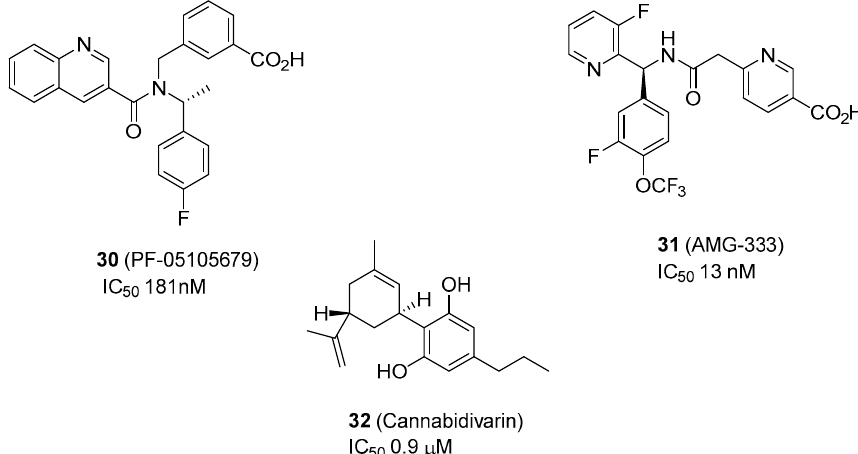
Figure 3. Selective TRPM8 antagonists that have reached clinical trials.